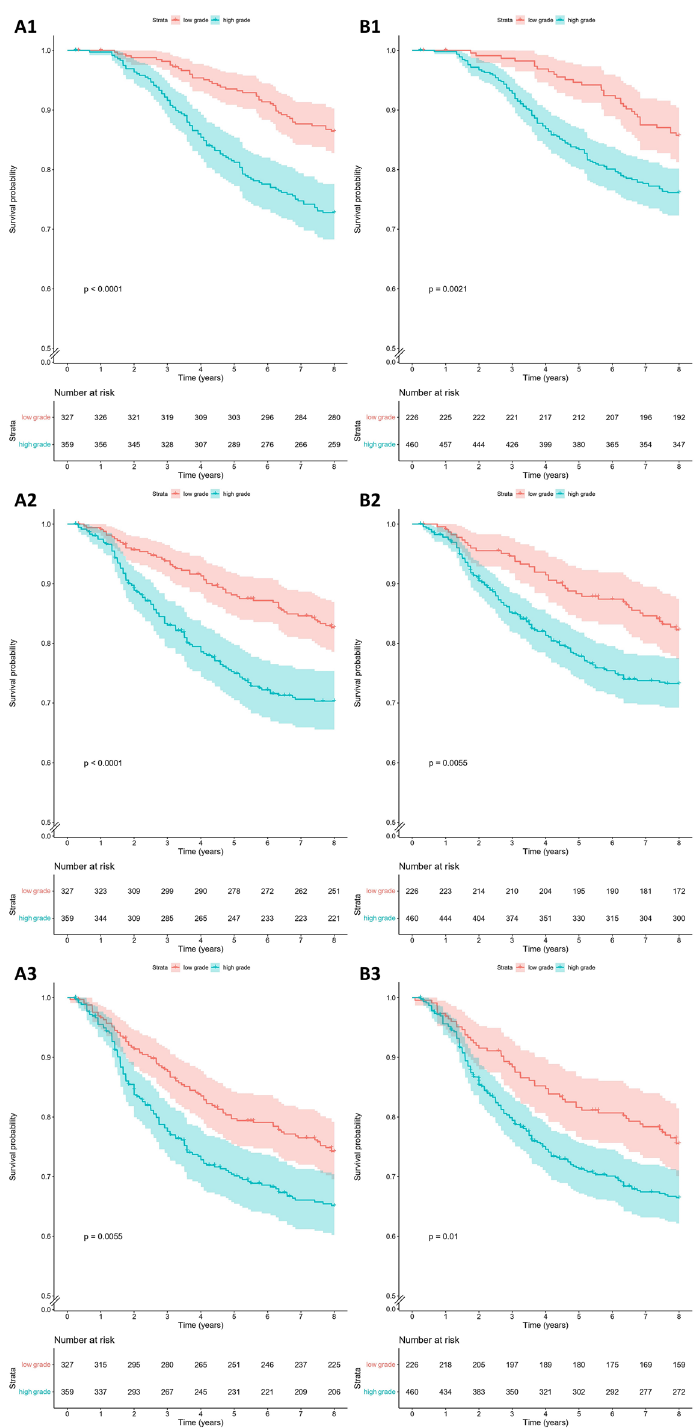
Figure 3. Kaplan–Meier survival curves for young breast cancer patients grouped by low/intermediate versus high grade tumors as assigned by pathologists ( A ) and the deep learning model ( B ) for overall survival ( 1 ), distant recurrence free survival ( 2 ) and recurrence free survival ( 3 ). These results are on the test set ( n =